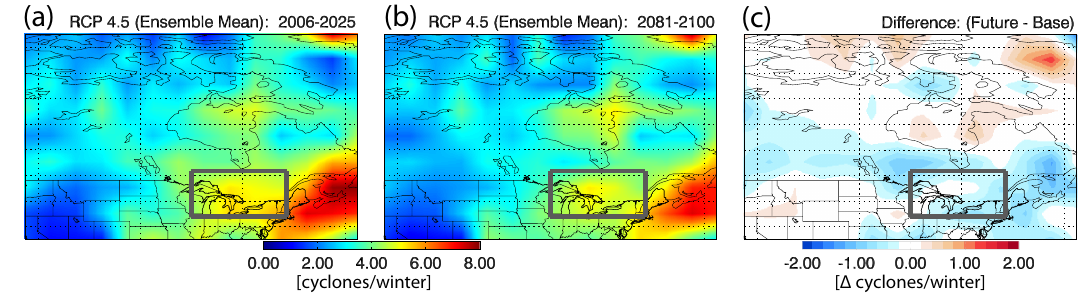
Fig. 5. Spatial distribution of GFDL CM3 cyclone frequencies during winter (DJF) for the RCP 4.5 ensemble mean. (a) Base period: 2006– 2025. (b) Future period: 2081–2100. (c) Difference between (a) and (b) . Gray box bounds the GLST.